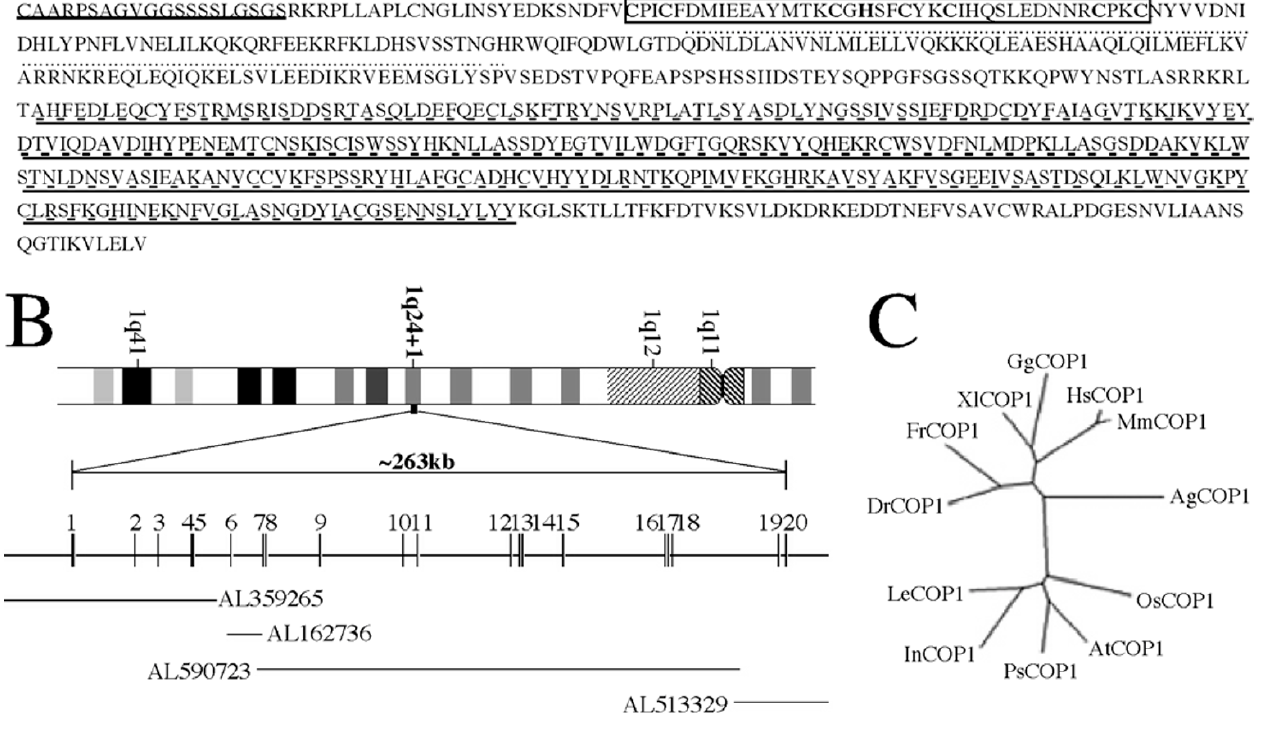
Figure 1 The general characteristics of the mammalian COP1 proteins and genes. (A) Predicted amino acid sequence of HsCOP1. The N-terminal glycine-serine rich extension is underlined. The RING finger domain is boxed. The coiled-coil domain is indicated by dotted lines. The WD40 repeats are double underlined by solid lines and dashed lines. The sequence data were deposited in GenBank/EMBL/DDBJ under the accession number AF508940. (B) The genomic structure of the HsCOP1 gene. The HsCOP1 gene is located on chromosome 1 at position 1q24+1 based on the ideogram. Exons, represented by boxes with the exon numbers indicated above, are distributed over a solid line representing introns, according to propor- tion. The length of the HsCOP1 gene is indicated above the gene structure diagram. The corresponding sequenced human genomic BAC clones, represented by solid lines, are aligned under the HsCOP1 gene diagram. The HsCOP1 genomic sequence data are available in the Third Party Annotation Section of the DDBJ/EMBL/GenBank databases under the accession number TPA: BK000438. (C) A phylogenetic tree of COP1 proteins from representative species of both animal and plant kingdoms. The phylogenetic tree is constructed by ClustalW software [57], using protein sequences corresponding to the first 200 amino acids of HsCOP1. The protein sequence of HsCOP1 (human) is available under GenBank accession number AF508940. The protein sequence of MmCOP1 (mouse) is available under GenBank accession number AF151110. The partial protein sequence of XlCOP1 (xenopus) was predicted from four xenopus EST clones (GenBank accession number BE506274, BE679680, BE026293 and BG345699). The partial protein sequence of GgCOP1 (chicken) was predicted from one chicken EST clone (GenBank accession number BM487594). The partial protein sequence of DrCOP1 (zebrafish) was predicted from one EST clone (GenBank accession number AI959013). The partial protein sequence of FrCOP1 (fugu) was predicted from scaffold 5023 of the draft fugu genomic sequence. The protein sequence of AgCOP1 (mosquito) was predicted from the scaffold CRA_x9P1GAV59LQ of the draft mosquito genomic sequence. The protein sequences of AtCOP1 (Arabidopsis), PsCOP1 (pea), LeCOP1 (tomato), InCOP1 (morning glory), and OsCOP1 (rice) are available under GenBank accession number L24437, Y09579, AF029984, AF315714, AB040053,